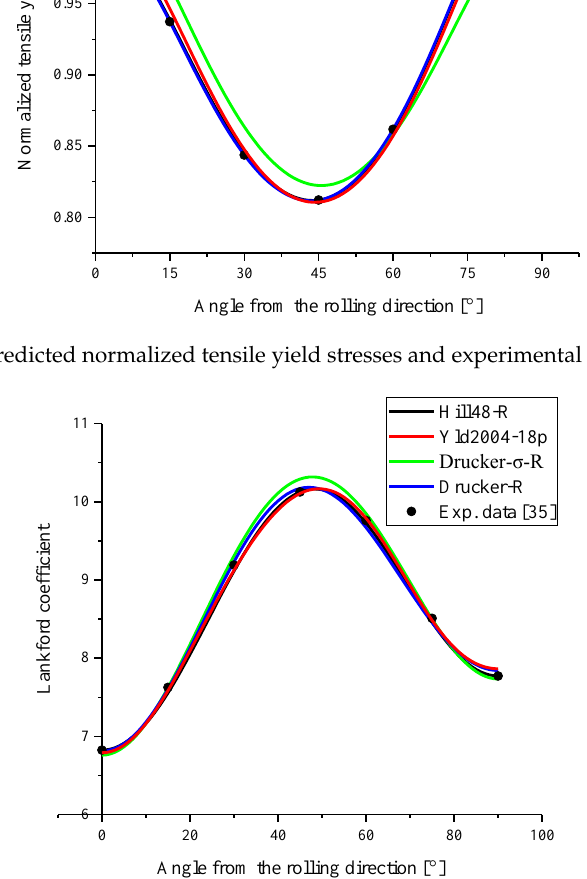
18 of 25 Figure 12. Predicted yield locus of various criteria with experimental data in-plane stress. Figures 13–15 illustrate the comparisons between experimental and numerical normalized